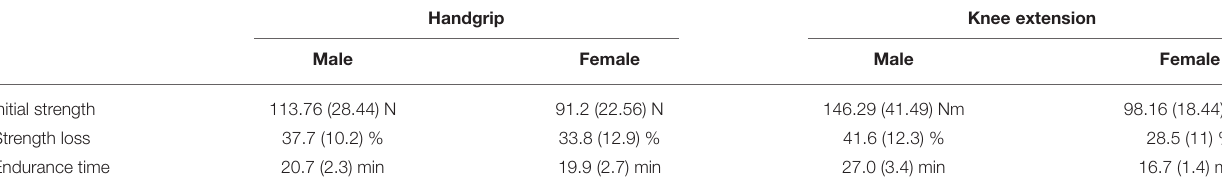
TABLE 2 | Strength and fatigue indicators for males and females during handgrip and knee extension exercises. Handgrip Knee extension Male Female Male